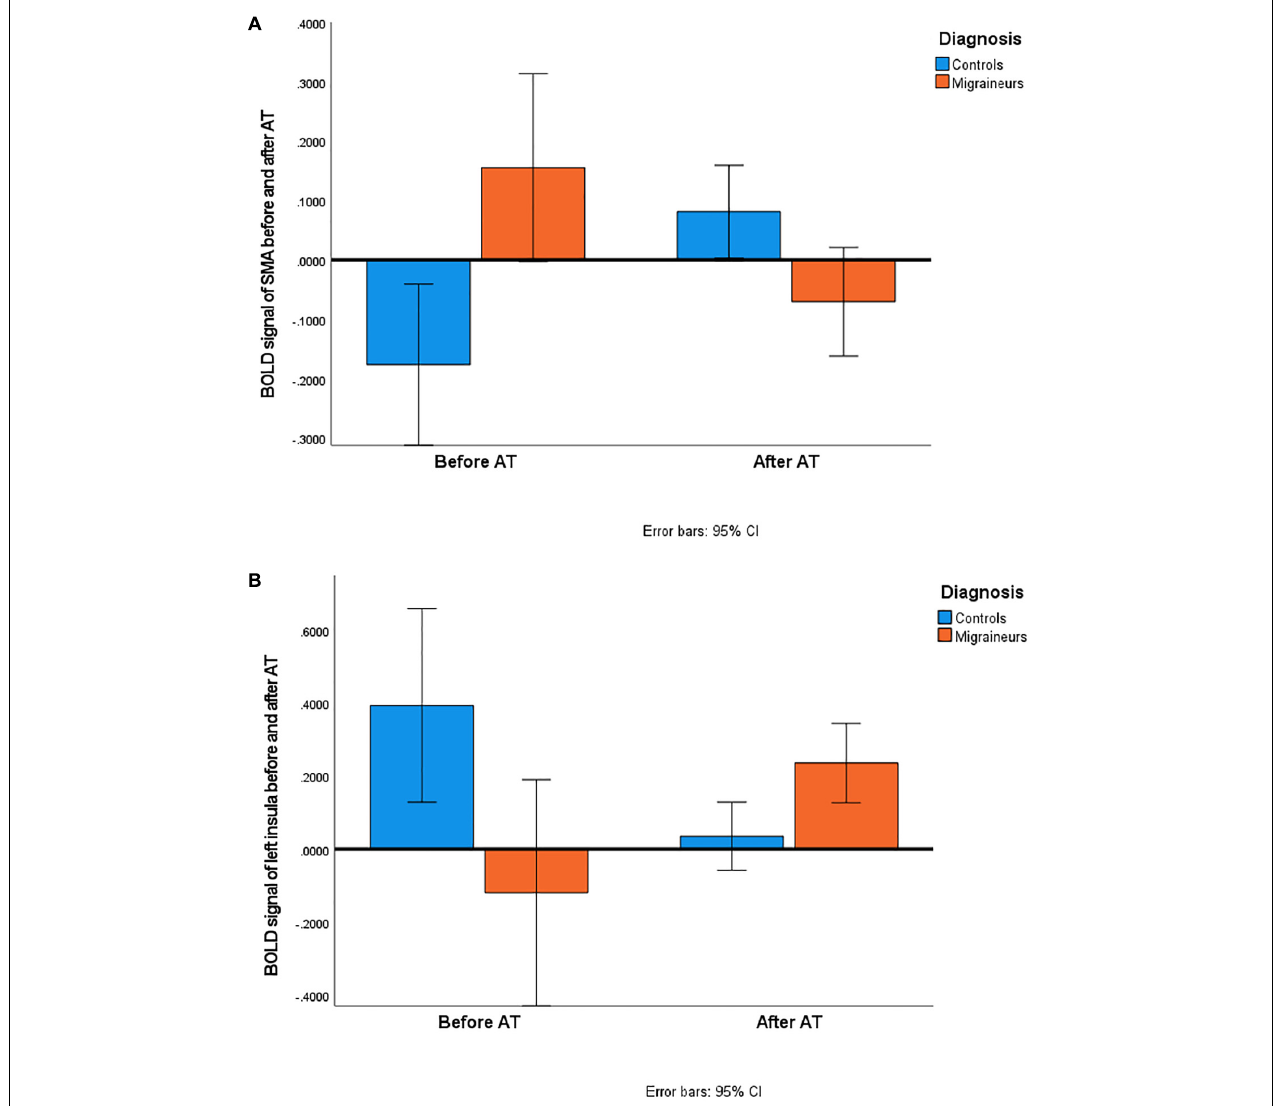
FIGURE 2 | Comparison of BOLD signals in controls and migraineurs before and after AT. (A) Activation of left medial frontal gyrus [supplementary motor area (SMA)] increased in controls and decreased in migraineurs in response to fearful faces by the end of the 16-week AT. (B) Activation of left insula increased in migraineurs and decreased in controls in response to happy faces by the end of the 16-week AT. There is a significant difference between BOLD signal of controls and migraineurs both before AT (SMA: Mann-Whitney U -test = 23, p = 0.002; insula: Mann-Whitney U -test = 21, p = 0.001) and after AT (SMA: Mann-Whitney U -test = 42, p = 0.036; insula: Mann-Whitney U -test = 36, p = 0.016). The difference decreased by the end of the AT course in both